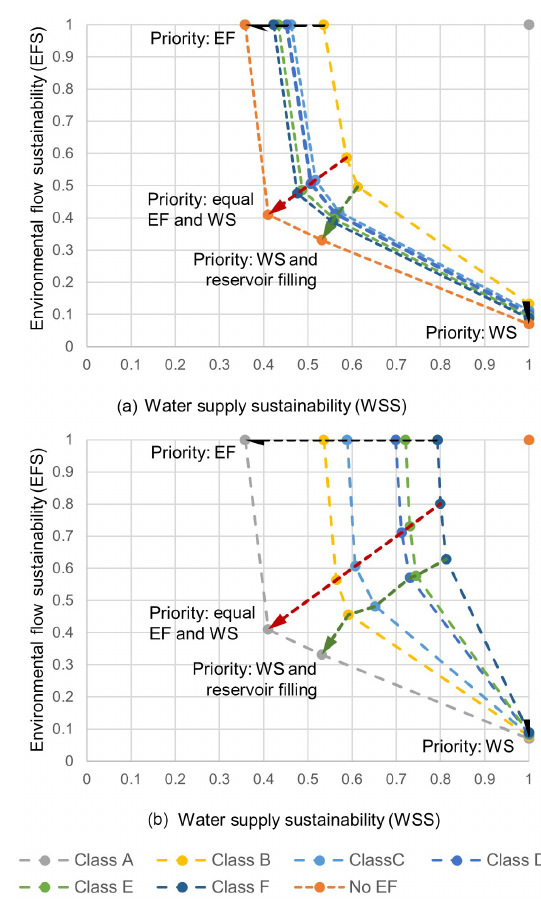
Figure 3. Variation of WSS and EFS when increasing levels of yields are extracted while trying to satisfy EF at EMC “A” (a) ; when increasing levels of EF are released while trying to extract yields at “No EF” level (b) for a storage capacity of 1MAR with different priorities assigned to water supply and EF